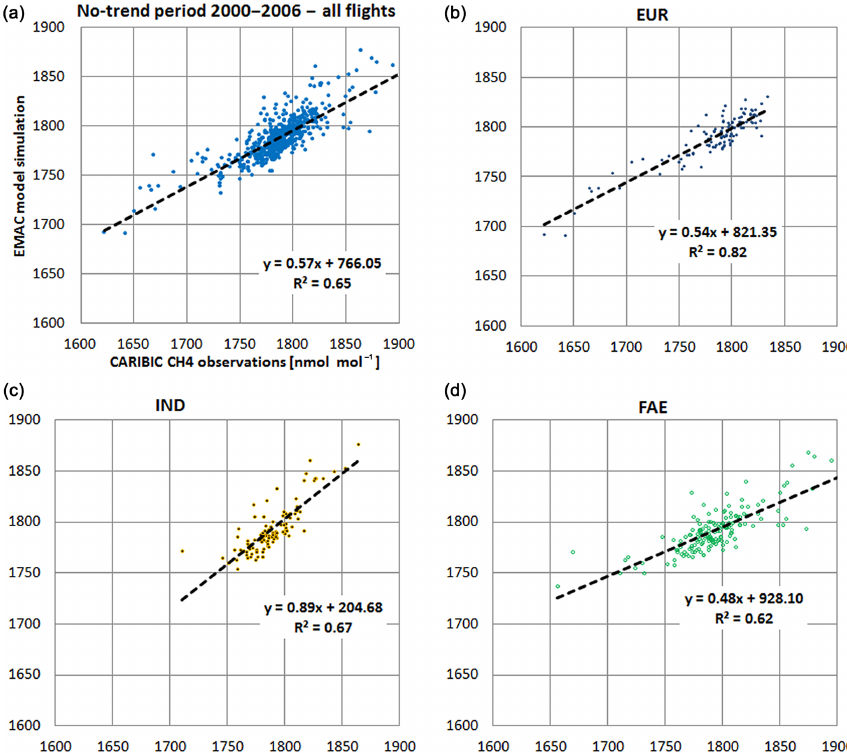
Figure 8. Correlation CARIBIC flight samples ( x axis) vs. EMAC simulations ( y axis) (nmolmol − 1 ) for all flights during the no-trend period (2000–2006) (a) and the main flight regions: India (IND), Europe (EUR), and the Far East (FAE).